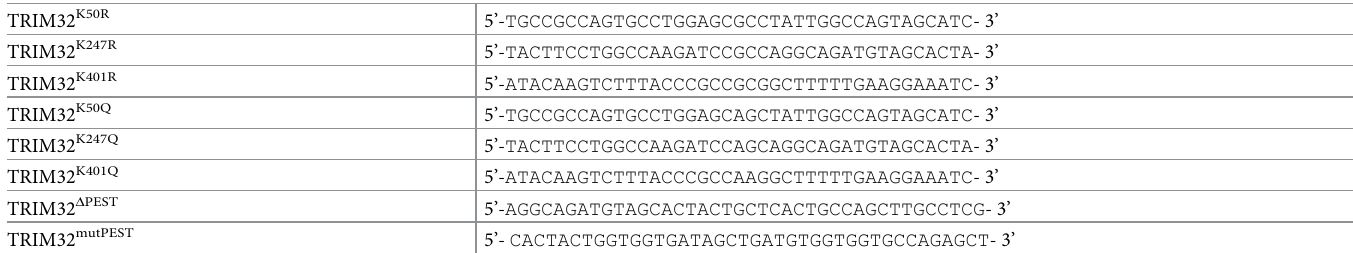
Table 2. Oligonucleotides used in this